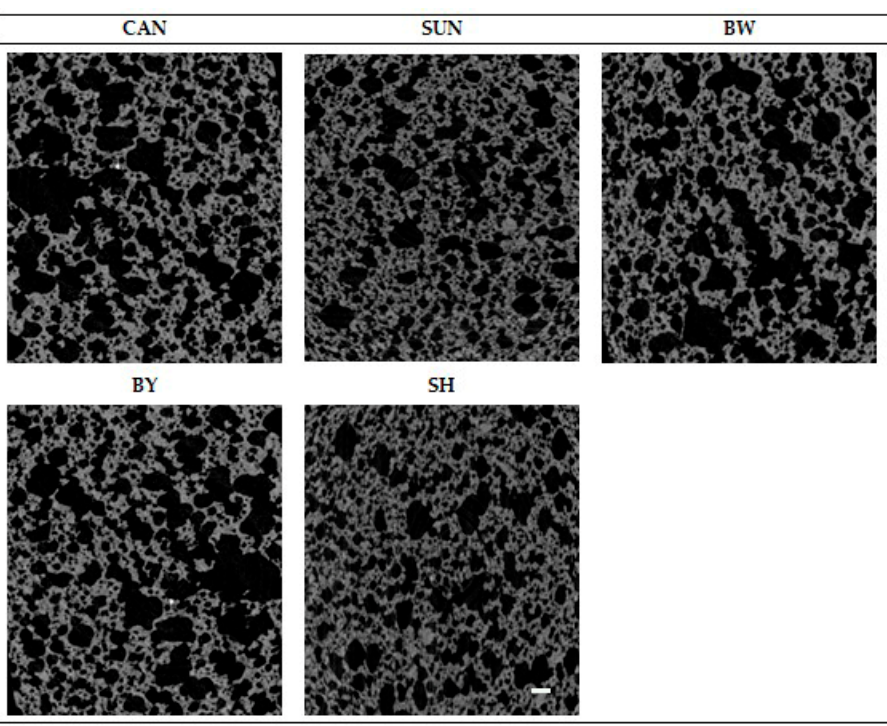
Figure 3. Two-dimensional (2D) reconstruction images of crumb of gluten-free muffins, containing shortening (SH) or oleogel with candelilla wax (CAN), sunflower wax (SUN), beeswax white (BW), or beeswax yellow (BY) as the fat component. Scale bar: 1 mm.